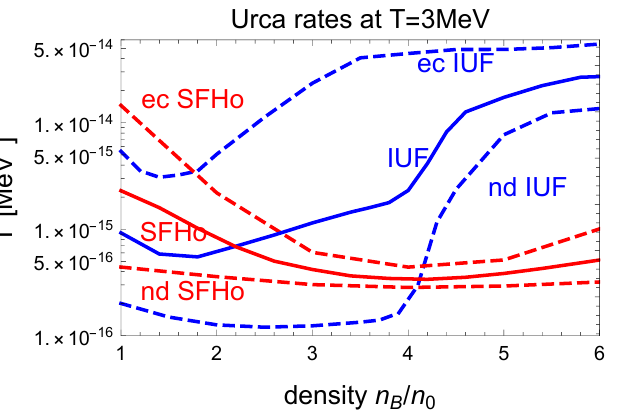
Figure 8. Urca (direct plus modified) rates for IUF and SFHo EoSs at T = 3MeV. When ∆ µ = 0 (dashed lines) the rates for neutron decay (nd) and electron capture (ec) do not balance. With the correct choice of ∆ µ (Figures 6 and 7) the neutron decay and electron capture rates (solid lines) become equal, and the system is in beta